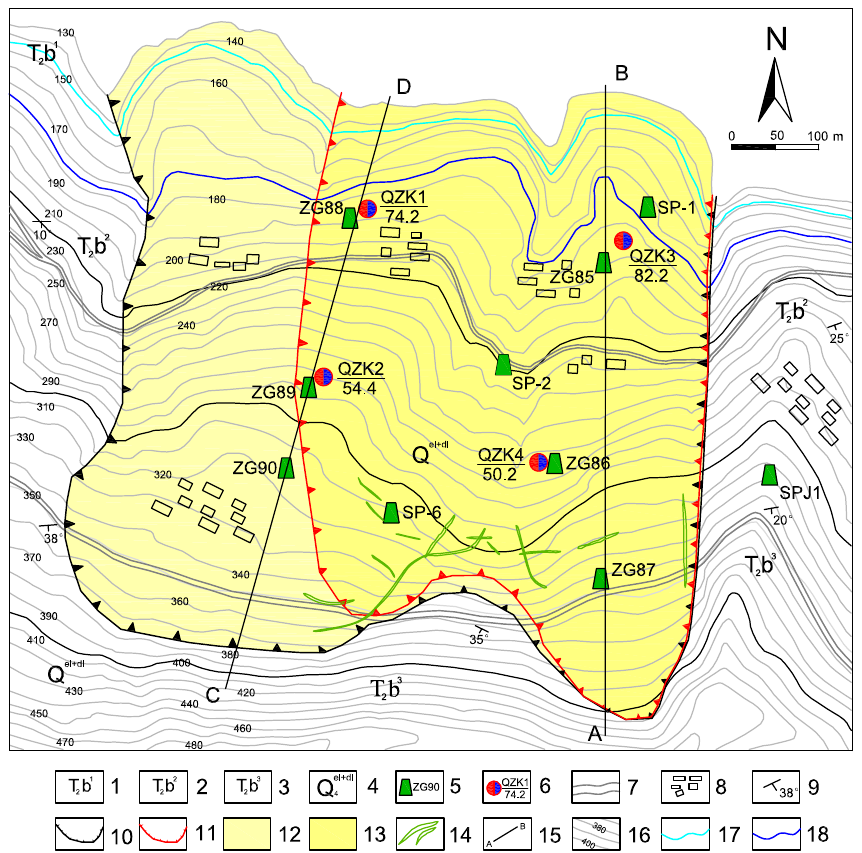
Figure 4. Geology and deformation monitoring map of Shuping landslide. (1) Middle Triassic Badong formation section; (1, 2) Middle Tri- assic Badong formation section; (2, 3) Middle Triassic Badong formation section; (3, 4) Quaternary colluviums; (5) GPS monitoring stations and number; (6) inclinometer monitoring hole and its depth (the unit of depth is the meter); (7) roads; (8) houses; (9) lithology orientation; (10) landslide boundary; (11) main sliding boundary; (12) western portion zone; (13) eastern portion zone; (14) cracks; (15) longitudinal section; (16) counter line; (17) reservoir water level (145m); (18) reservoir water level